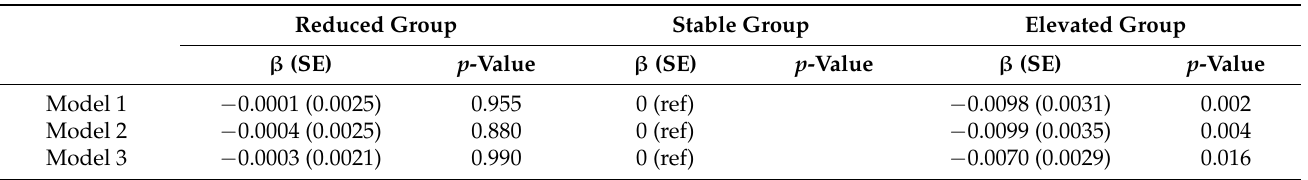
Table 3. Longitudinal analysis of mean difference in rate of change in global cognitive decline (SD per year) comparing categories of high-sensitivity C-reactive protein (Hs-CRP) change. Reduced Group Stable Group